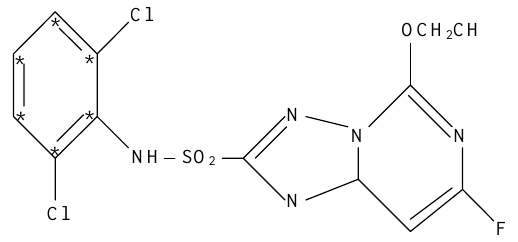
Figura 1. Fórmula estrutural da molécula do herbicida diclosulam. * Posição do 14 C. Fonte: Yoder et al.